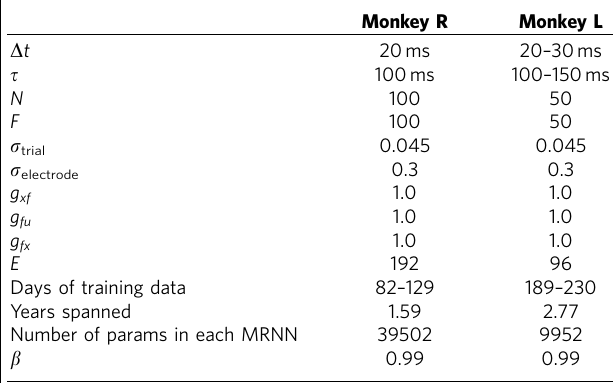
BMI, brain–machine interface; MRNN, multiplicative recurrent neural